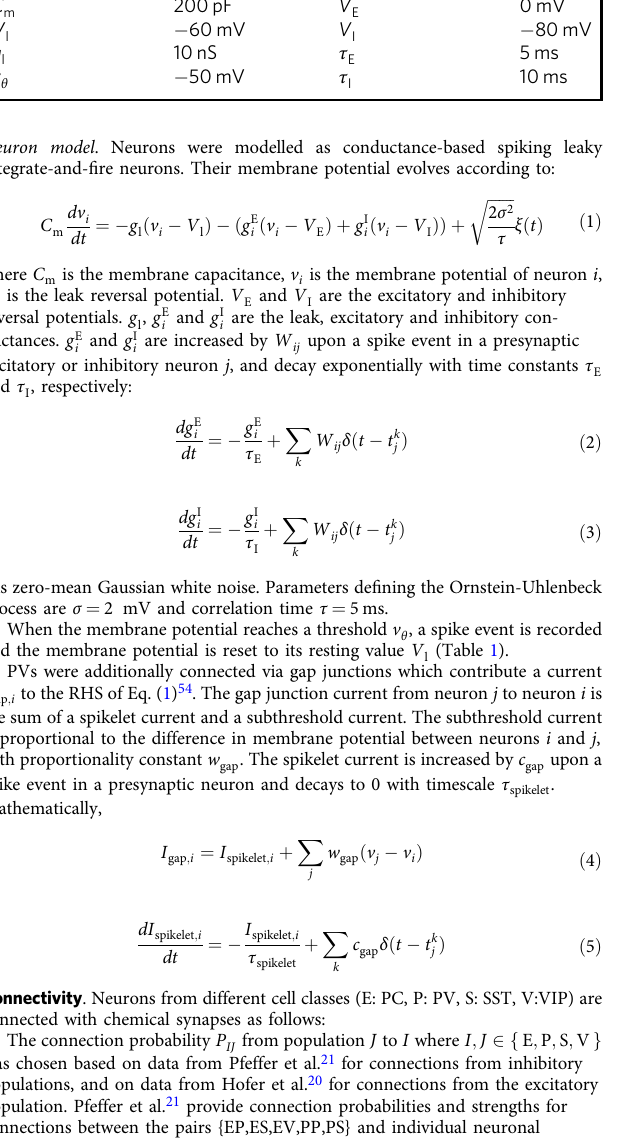
Table 1 Parameters of the leaky integrate-and- fi re neuron model Parameter Value